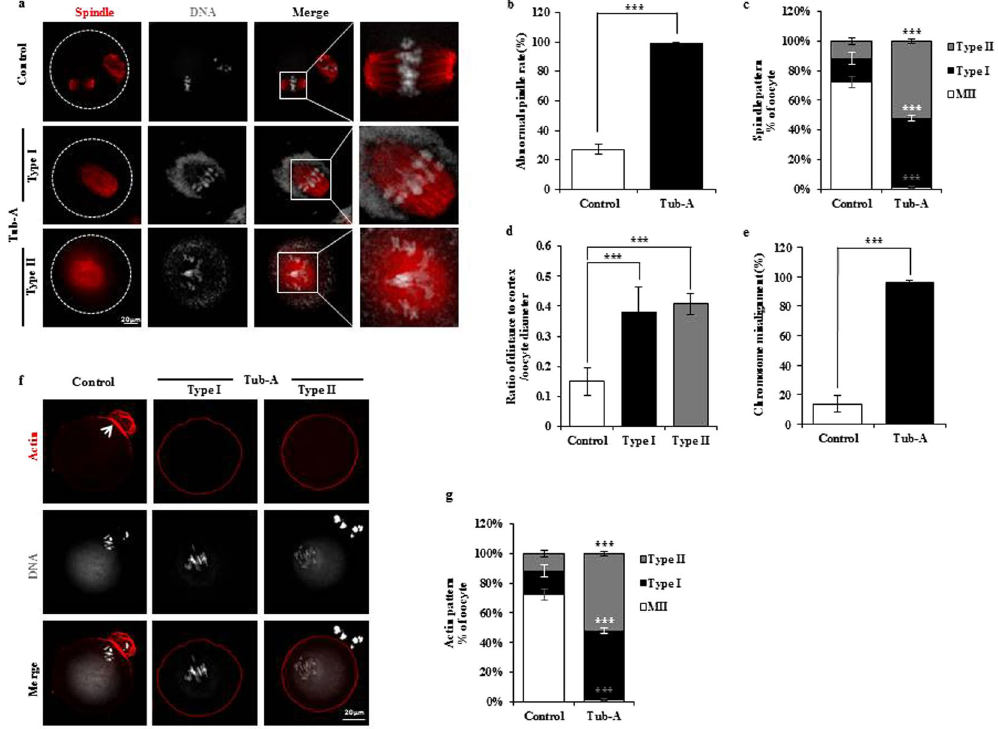
Figure 2. DMSO treatment disrupts spindle migration, positioning, and actin cap formation. ( a ) Oocytes were stained with α -tubulin antibody to visualise the spindle (green) and counterstained with TO-PRO-3 to visualise chromosomes (red). The white circle shows the oocyte boundary. Red bar, distance from the centroid of the spindle to the cortex; Blue bar, diameter of the oocyte. ( b , c ) Quantification of control and Tub-A-treated oocytes with spindle defects or percentage of Tub-A treated oocytes of different types. Data are expressed as mean ± SD percentage from three independent experiments in which > 50 oocytes were analysed. ( d ) The distribution of spindle locations in Tub-A treated and control oocytes. Spindle location is expressed as red bar length/blue bar length, where red bar is the distance between the chromatin and the cortex, and the blue bar is the oocyte diameter, as indicated in ( a ) n values are as indicated. *** p < 0.001. ( e ) Tub-A treatment during meiotic maturation significantly increases the proportion of oocytes with aberrant chromosome morphology compared to controls ( p = 0.000547). ( f ) Representative images showing the actin distribution in control and Tub-A treated oocytes. Arrowheads indicate the position of the actin cap. Red, actin; Grey, chromosome. ( g ) Quantification of control and Tub-A treated oocytes with different actin patterns in the mouse